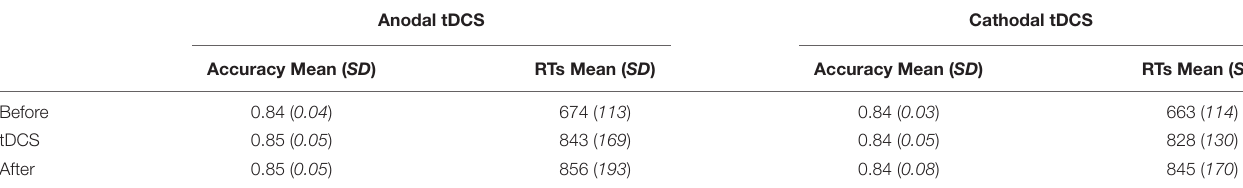
TABLE 1 | Mean and standard deviations shown separately for accuracy (A (cid:48) ) and RTs on the verbal WM updating task in the two stimulation sessions ( N = 19), split out for the three different blocks of the task and the anodal and cathodal tDCS stimulation condition. Anodal